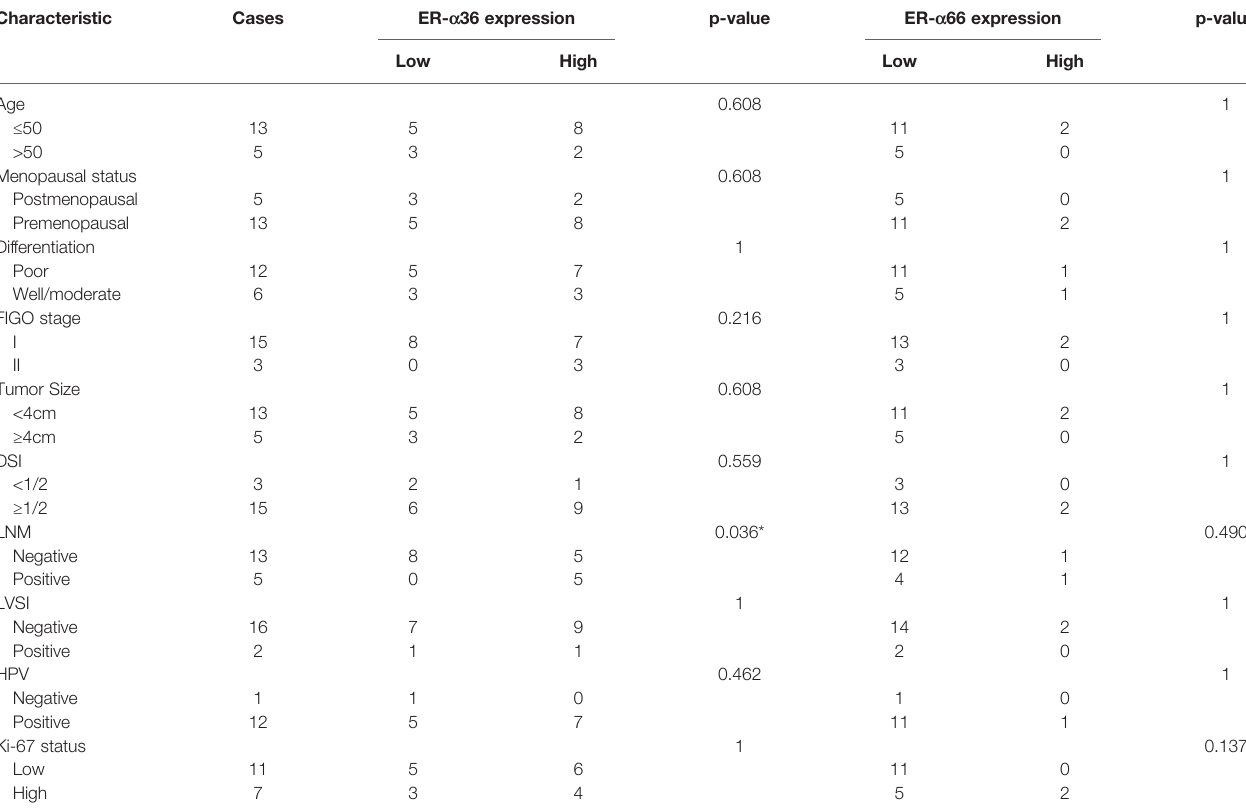
TABLE 2 | Association between ER- a 36/ER- a 66 expression and clinicopathologic characteristics of cervical AC patients.